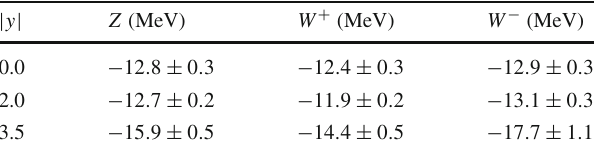
Fig. 2 The shift Δ V and the coefficient H V as a function of y averaged over the various quark flavours that enter the tree-level production of √ W ± and Z in pp collisions at s = 13 TeV. On the right the equivalent scale for the correspondent H V √ s = 13 Table 1 Numerical values of the shift Δ V in pp collision at TeV, for three selected values of | y | with their PDF